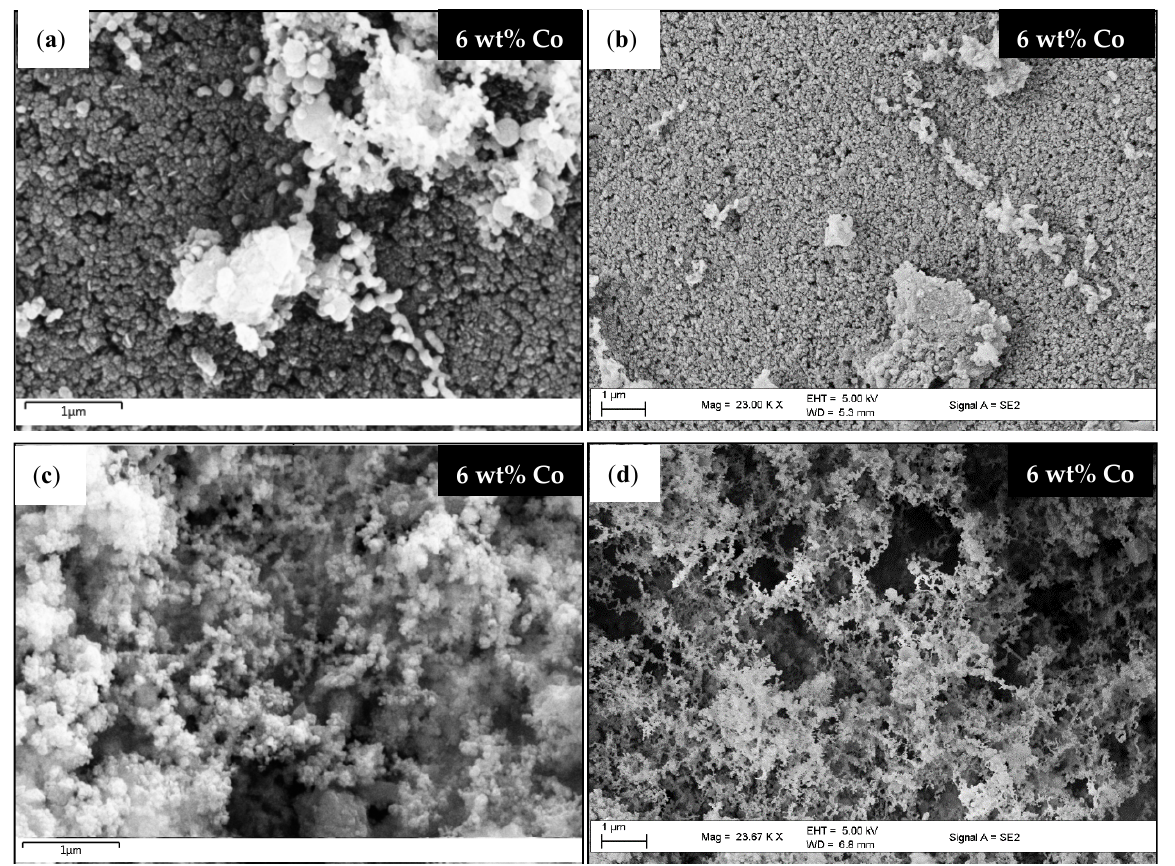
Figure 18. SEM micrographs of 6 wt% Co catalysts; ( a , b ) fresh catalyst, ( c , d ) used catalyst.